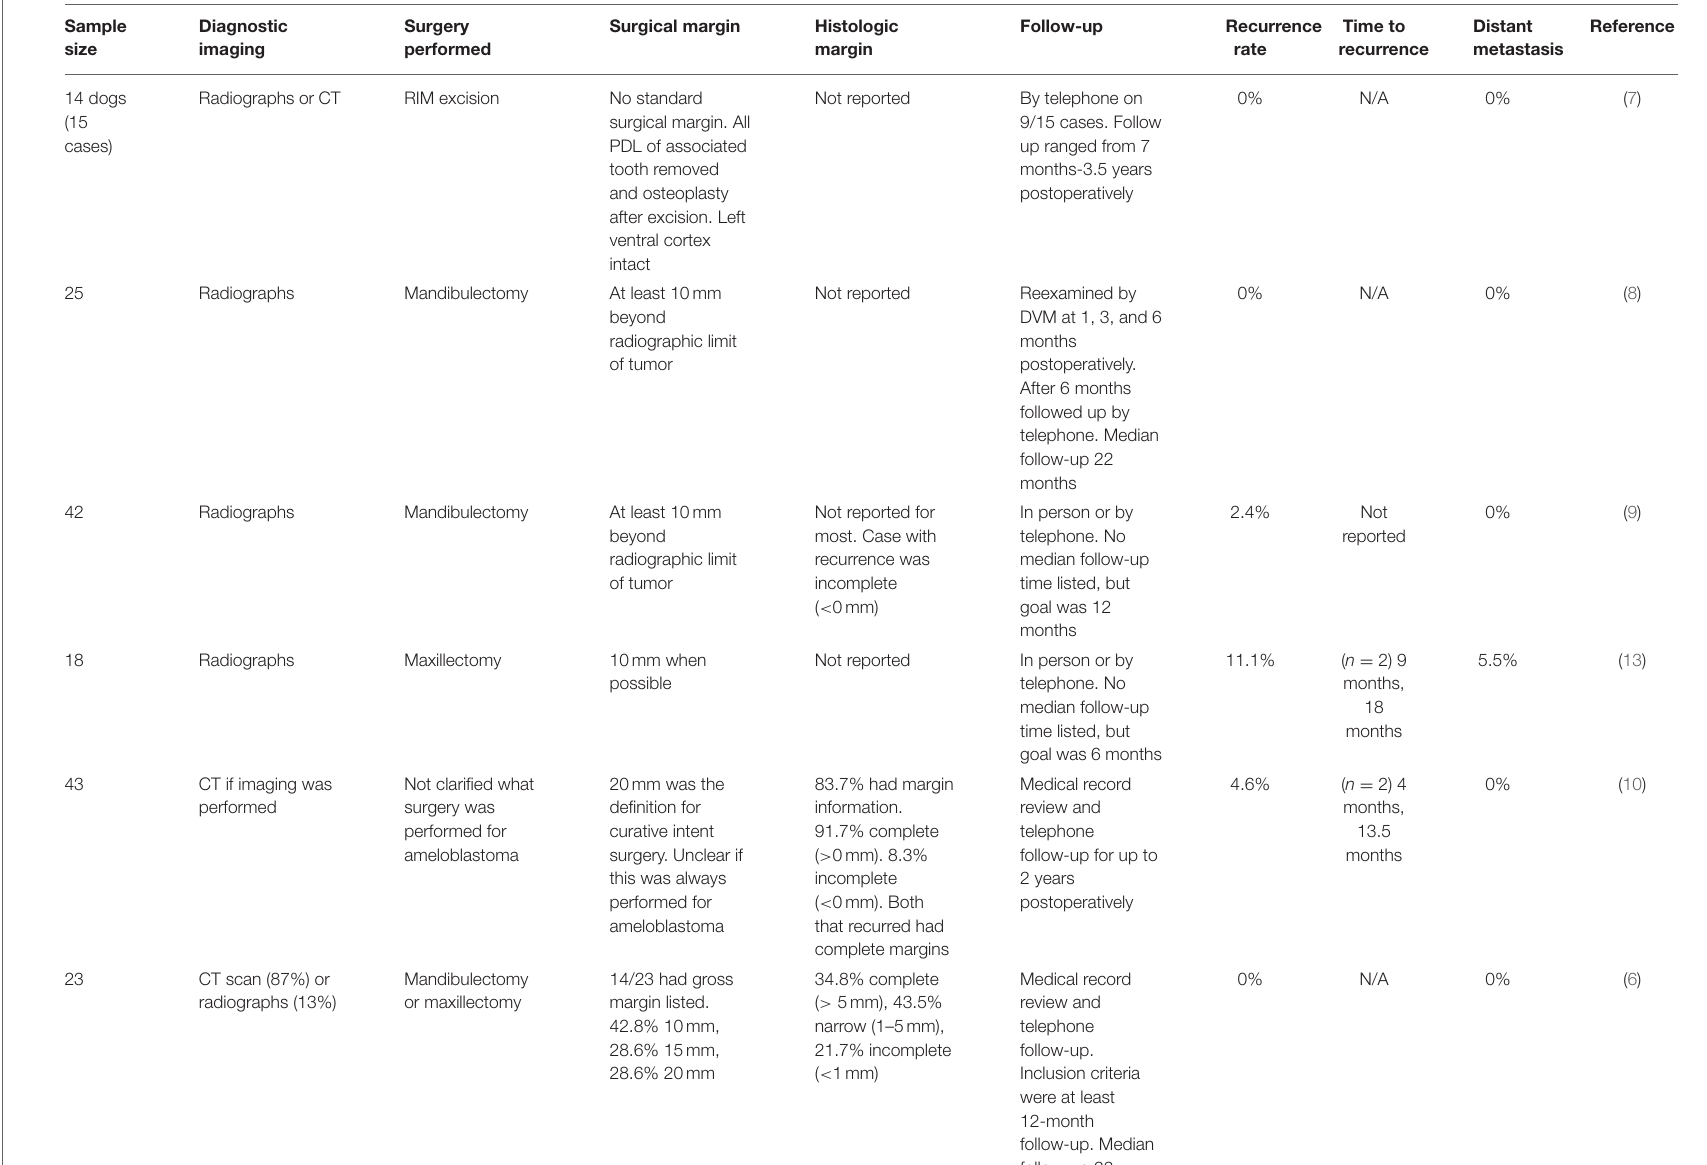
TABLE 1 | Studies that evaluated the recurrence rate of ameloblastoma following surgery with a safety margin. Sample